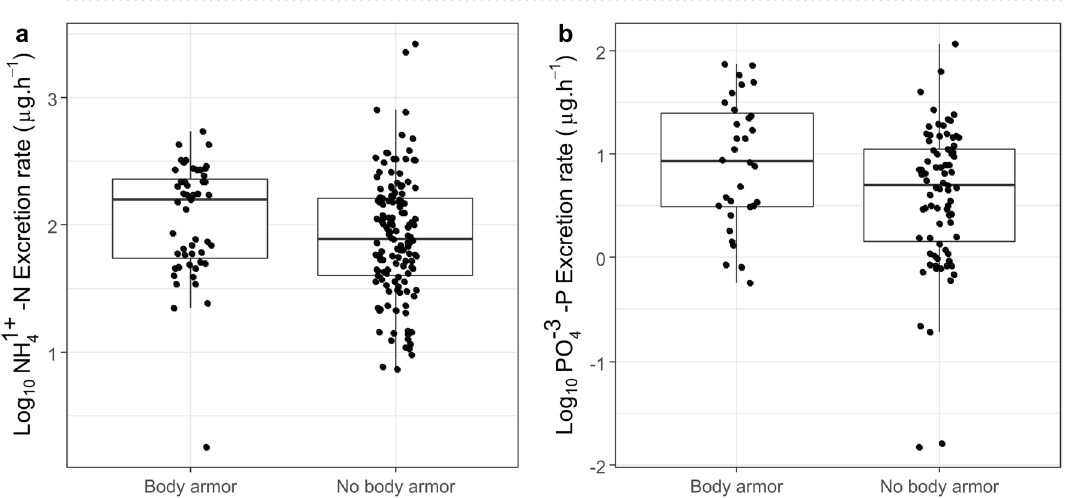
Figure 2. Excretion rates of ( a ) N and ( b ) P in armored versus non-armored fish species.